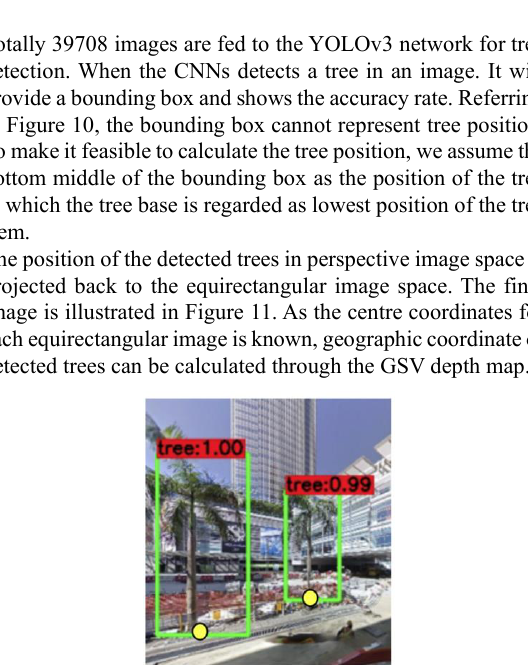
Figure 10. Yellow dots represent the position of the detected trees in perspective image